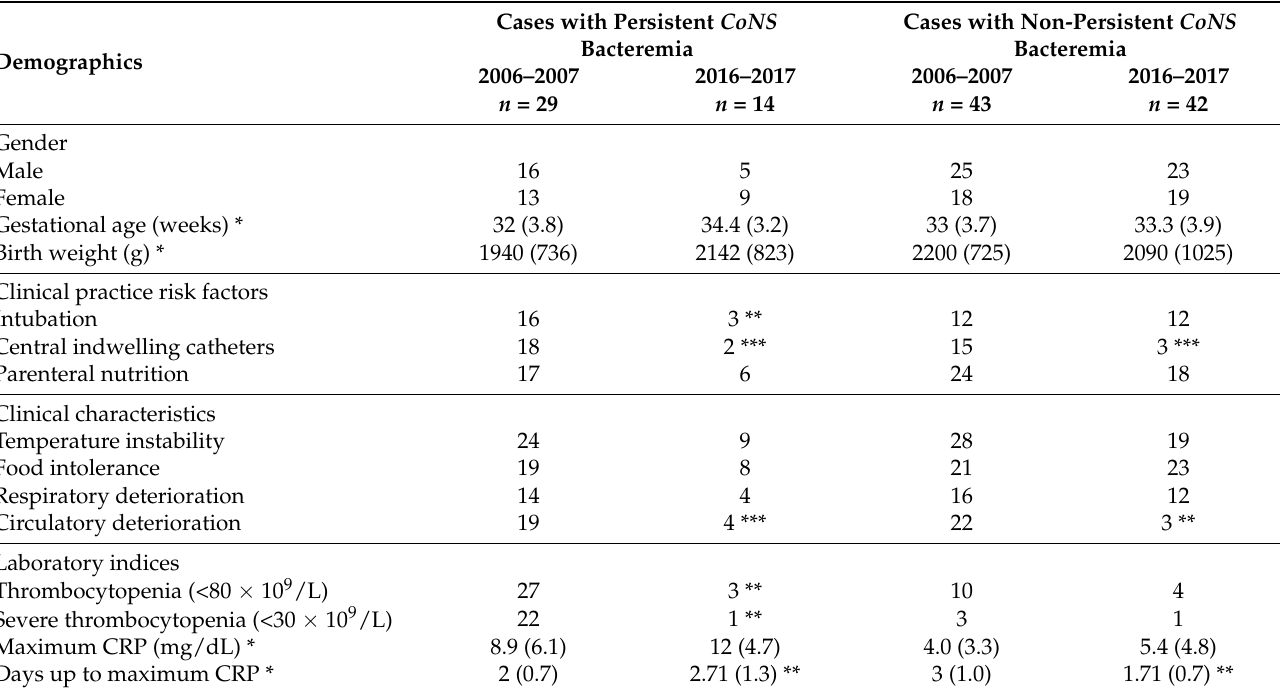
Table 3. Comparison of characteristics among neonates between the periods 2006–2007 and 2016–2017